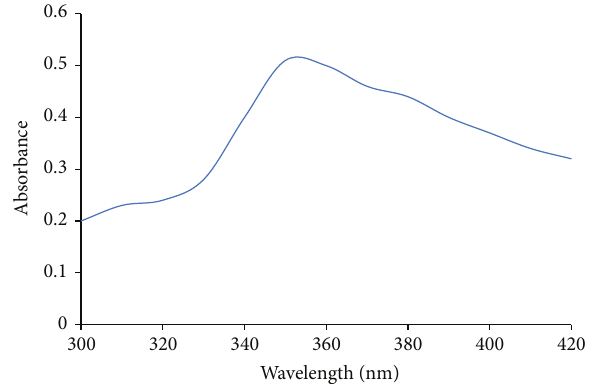
charged electrode under the applied potential, suggesting that the surface of BSA wrapped ZnWO 4 is negatively charged.